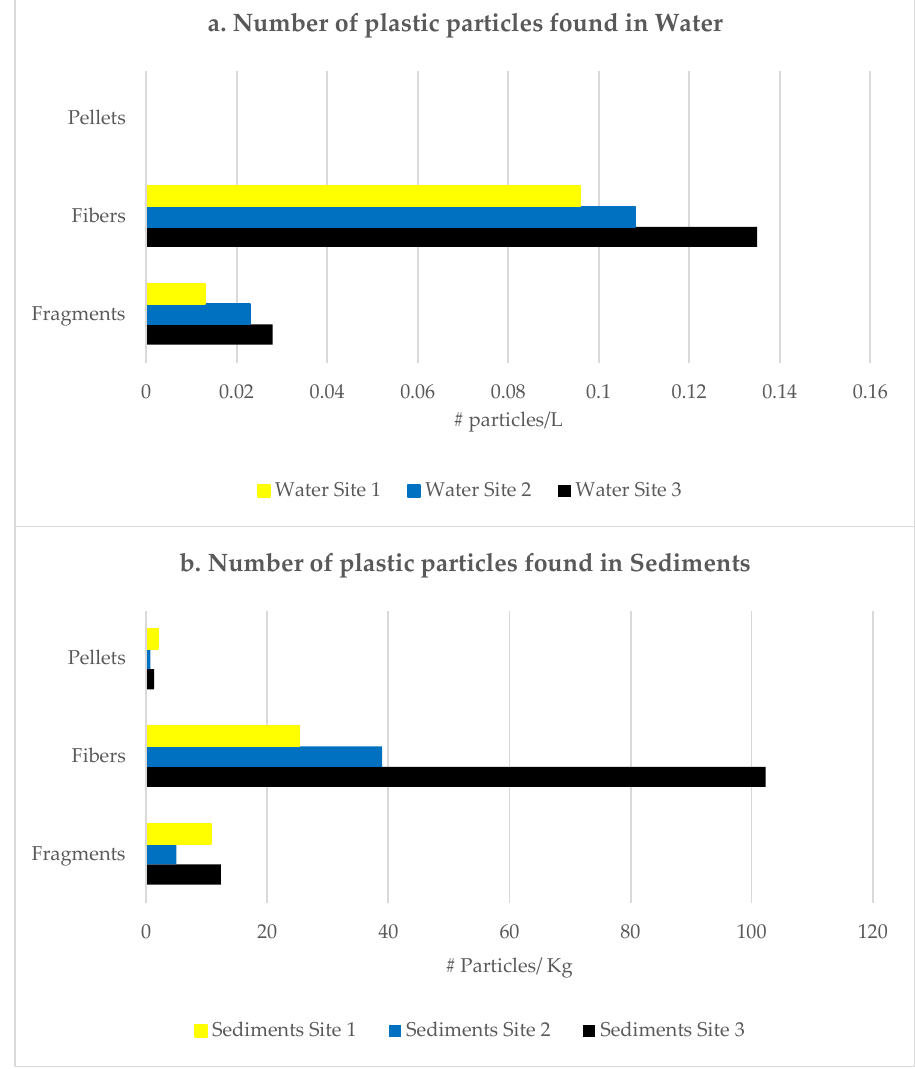
Figure 2. Number of microplastic particles (Graphic a. Shows # particles/L, Graphic b. Shows # particles/kg for sediments) found in each site according to their shape.